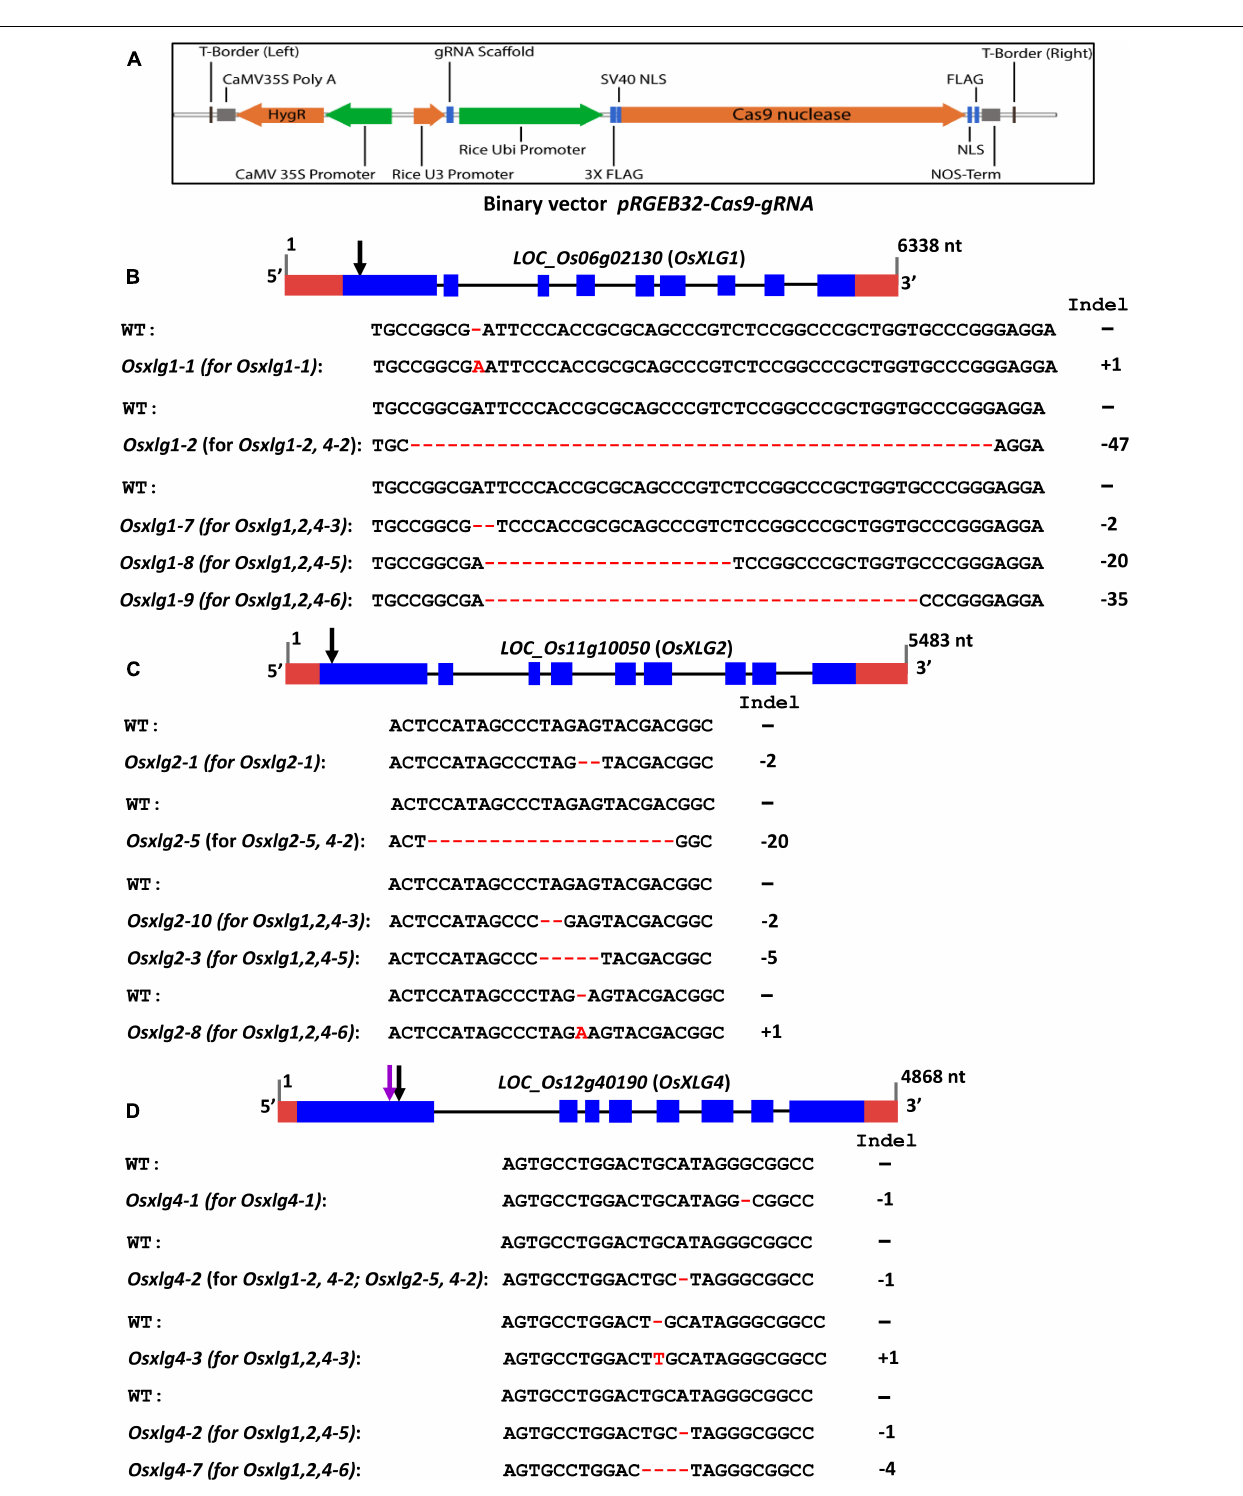
FIGURE 2 | Rice OsXLG s gene model, CRISPR/Cas9 vector map, positions of the guide RNAs (gRNA) and mutations. (A) A schematic of the binary vector along with Cas9 and position of gRNA (pRGEB32-Cas9-gRNA). (B–D) Rice OsXLG1 ( LOC_Os06g02130 ), OsXLG2 ( LOC_Os11g10050 ), and OsXLG4 ( LOC_Os12g40190 ) gene model from Phytozome 12.0 Oryza sativa v7_JGI . nt, nucleotides. Blue boxes indicate exons, black lines indicate introns, and red boxes are the 5 (cid:48) and 3 (cid:48) untranslated regions (UTRs). The indel patterns are shown in red color. Black arrows indicate the position of the nucleotide deletion and substitution mutations in the OsXLG1 , OsXLG2, OsXLG4 single, double, and triple mutant, whereas purple arrow indicates mutation of OsXLG4 in double mutants (A–C) .